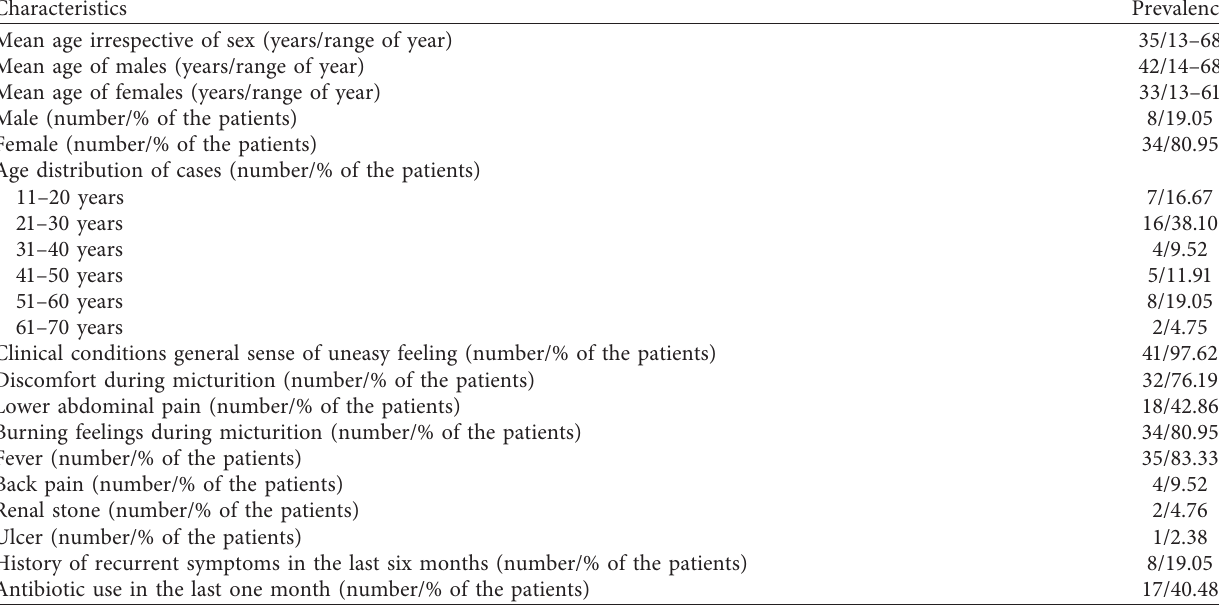
Table 2: Categorization and clinical symptoms of urinary tract infection patients ( n � 42).